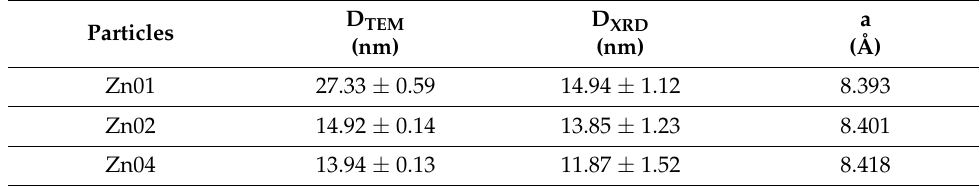
Table 1. Dimensions and lattice parameters of ZnF